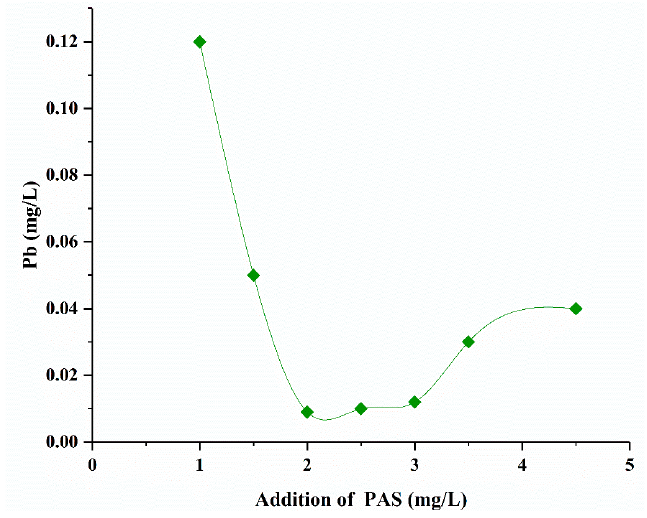
Figure 7. Lead (Pb) concentration in bleeding after 24 h of pre-setting.